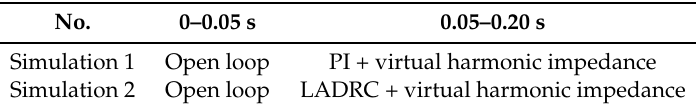
Table 3. The Design of Simulations.